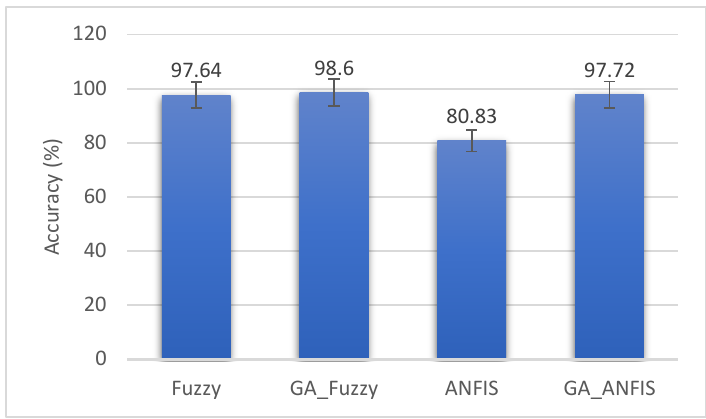
Fig. 5. Classification performance of the